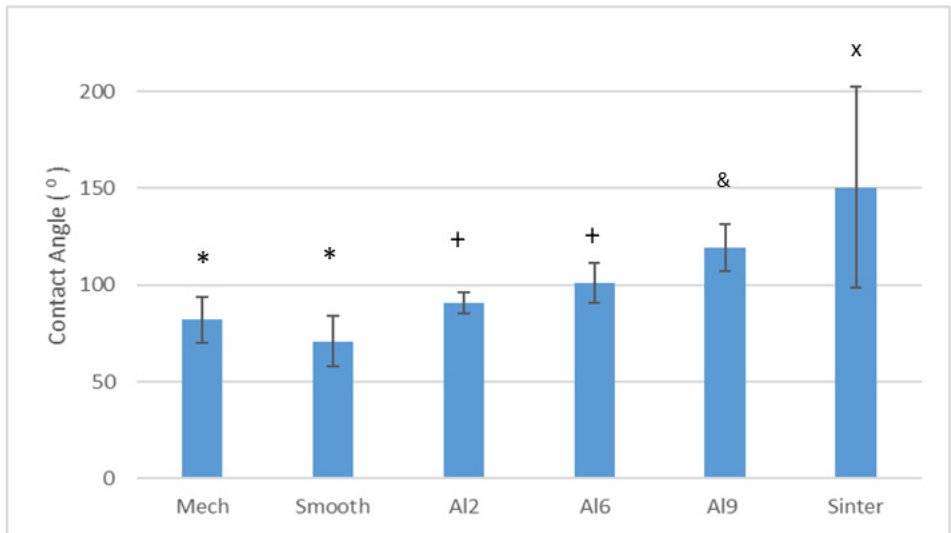
Figure 4. Contact angles obtained by each treatment. Each symbol means that the results were different with statistical significance to the other symbols at p < 0.01. The contact angles of the Sinter and Al9 samples showed statistically significant differences between all other surfaces. The Mech and Smooth samples did not show significant differences between them, but they did show significant differences between all the other samples. The same was true for the Al2 and Al6 samples, which did not differ statistically from each other but did differ from the rest of the